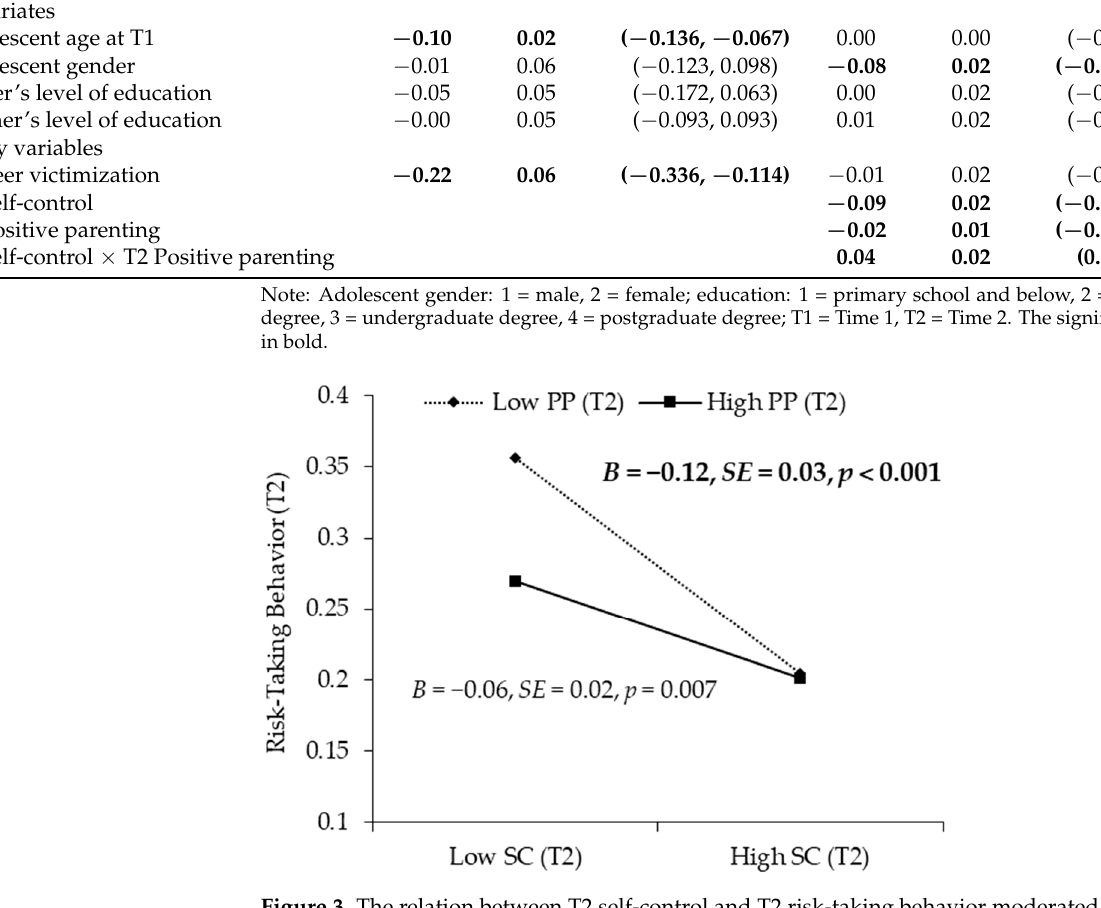
Figure 3. The relation between T2 self-control and T2 risk-taking behavior moderated by T2 positive parenting. Note: Unstandardized coefficients are reported. T1 = Time 1, T2 = Time 2; SC = self-control, PP = positive parenting.